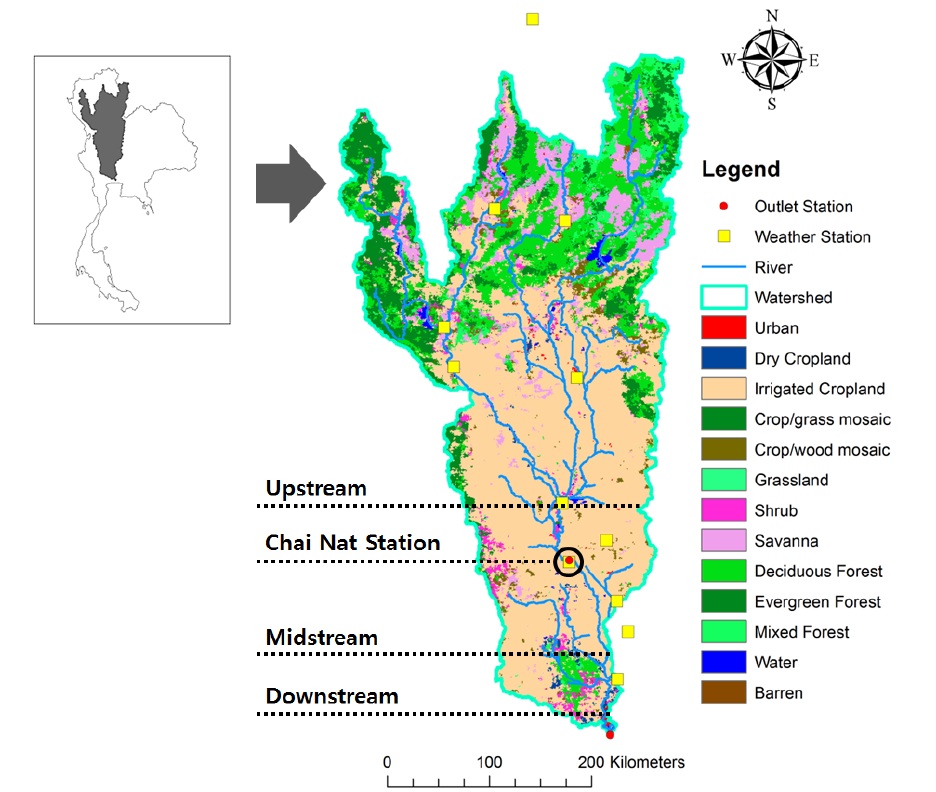
Figure 1. Chao Phraya River basin is shown in the map. It includes the locations of the twelve weather stations (yellow squares) of the basin as well as the outlet stations (red circles) of the river, which also served as monitoring stations. Chai Nat Station has been chosen for the SWAT model simulation of the